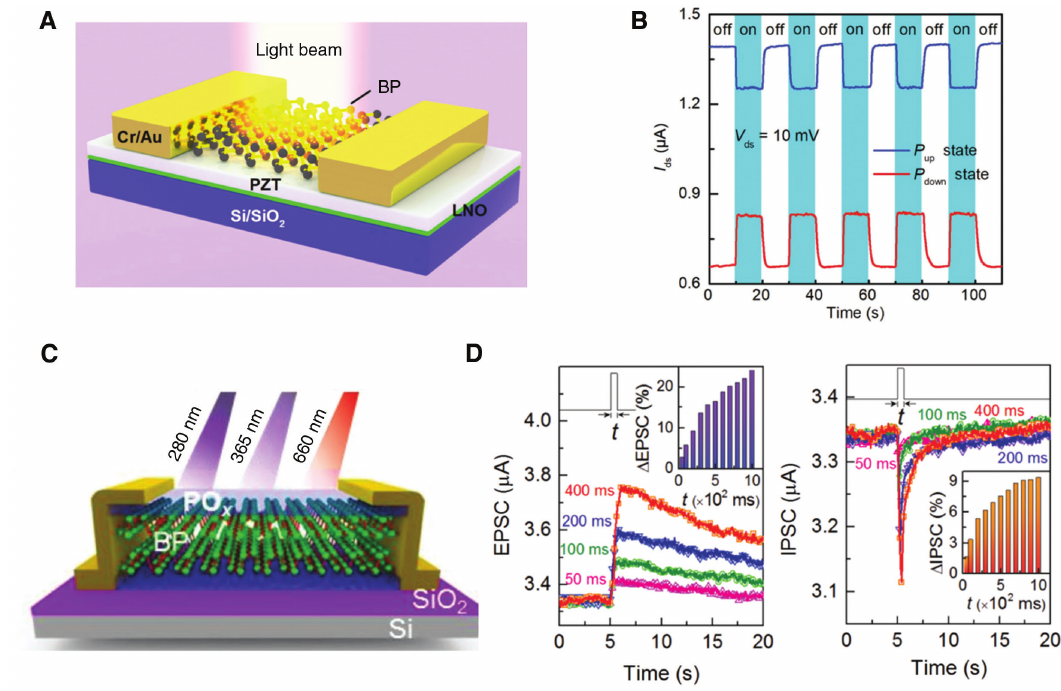
Figure 6: Photonic memristor on a BP-FET structure. (A) Schematic illustration and optical image of a photonic memristor in FeFET with PZT substrate. (B) Negative photoconductivity (NPC) and positive photoconductivity (PPC) at P and P states. (A, B) Reproduced with permission [29]. Copyright 2019, Wiley-VCH. (C) A schematic up down illustration of BP synaptic devices in a FET structure fabricated on a SiO /Si substrate. Monochromatic optical pulses with 280, 365, and 2 660 nm wavelengths are used as synaptic stimuli to emulate different neuronal functions. (D) 280nm optical stimulus-emulated EPSC and 363nm optical stimulus-emulated IPSC. (C, D) Reproduced with permission [39]. Copyright 2019,